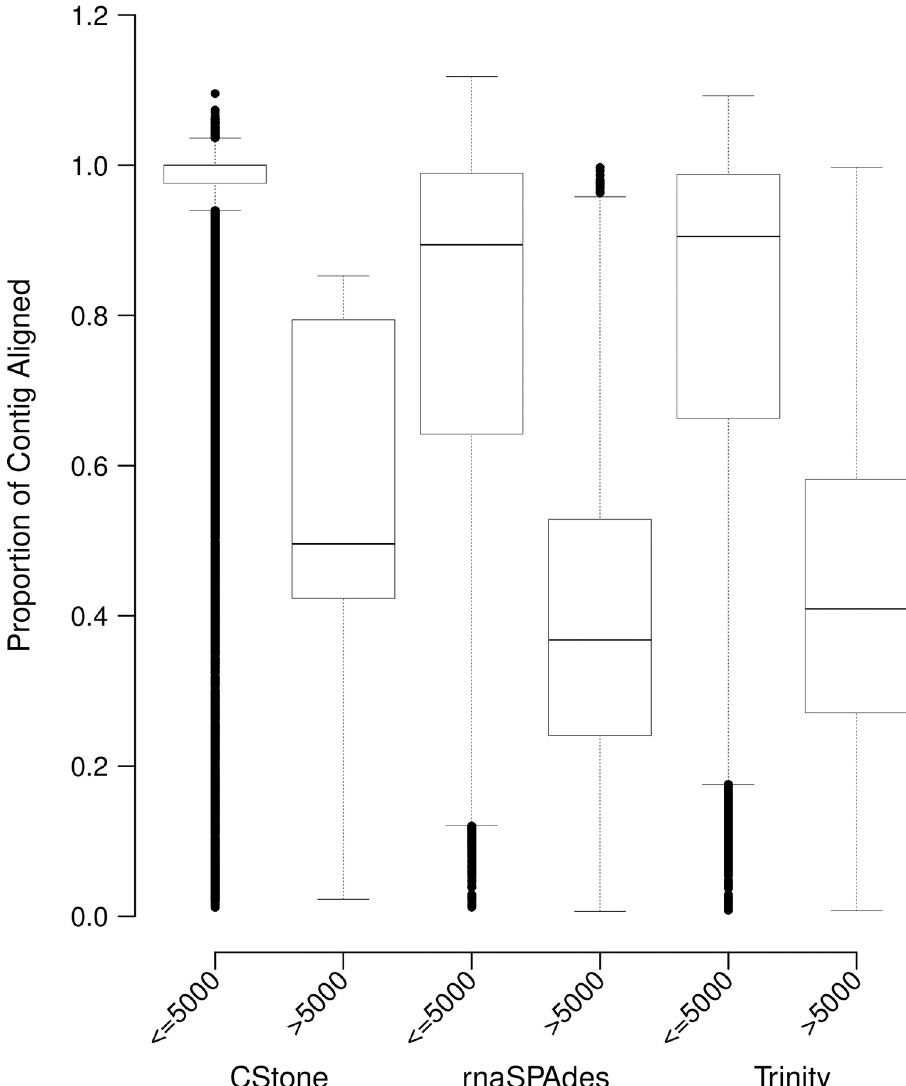
Fig 12. Proportions of each contig aligned. Boxes indicate the proportion of each contig aligned relative to its length. Values covered by box and whiskers are the same as those described for Fig